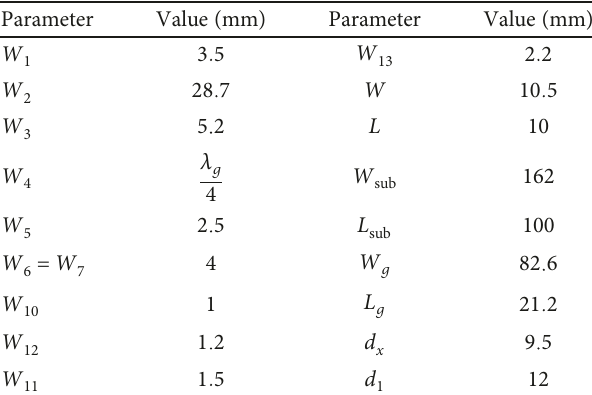
Table 3: Parameters of the proposed array antennas.